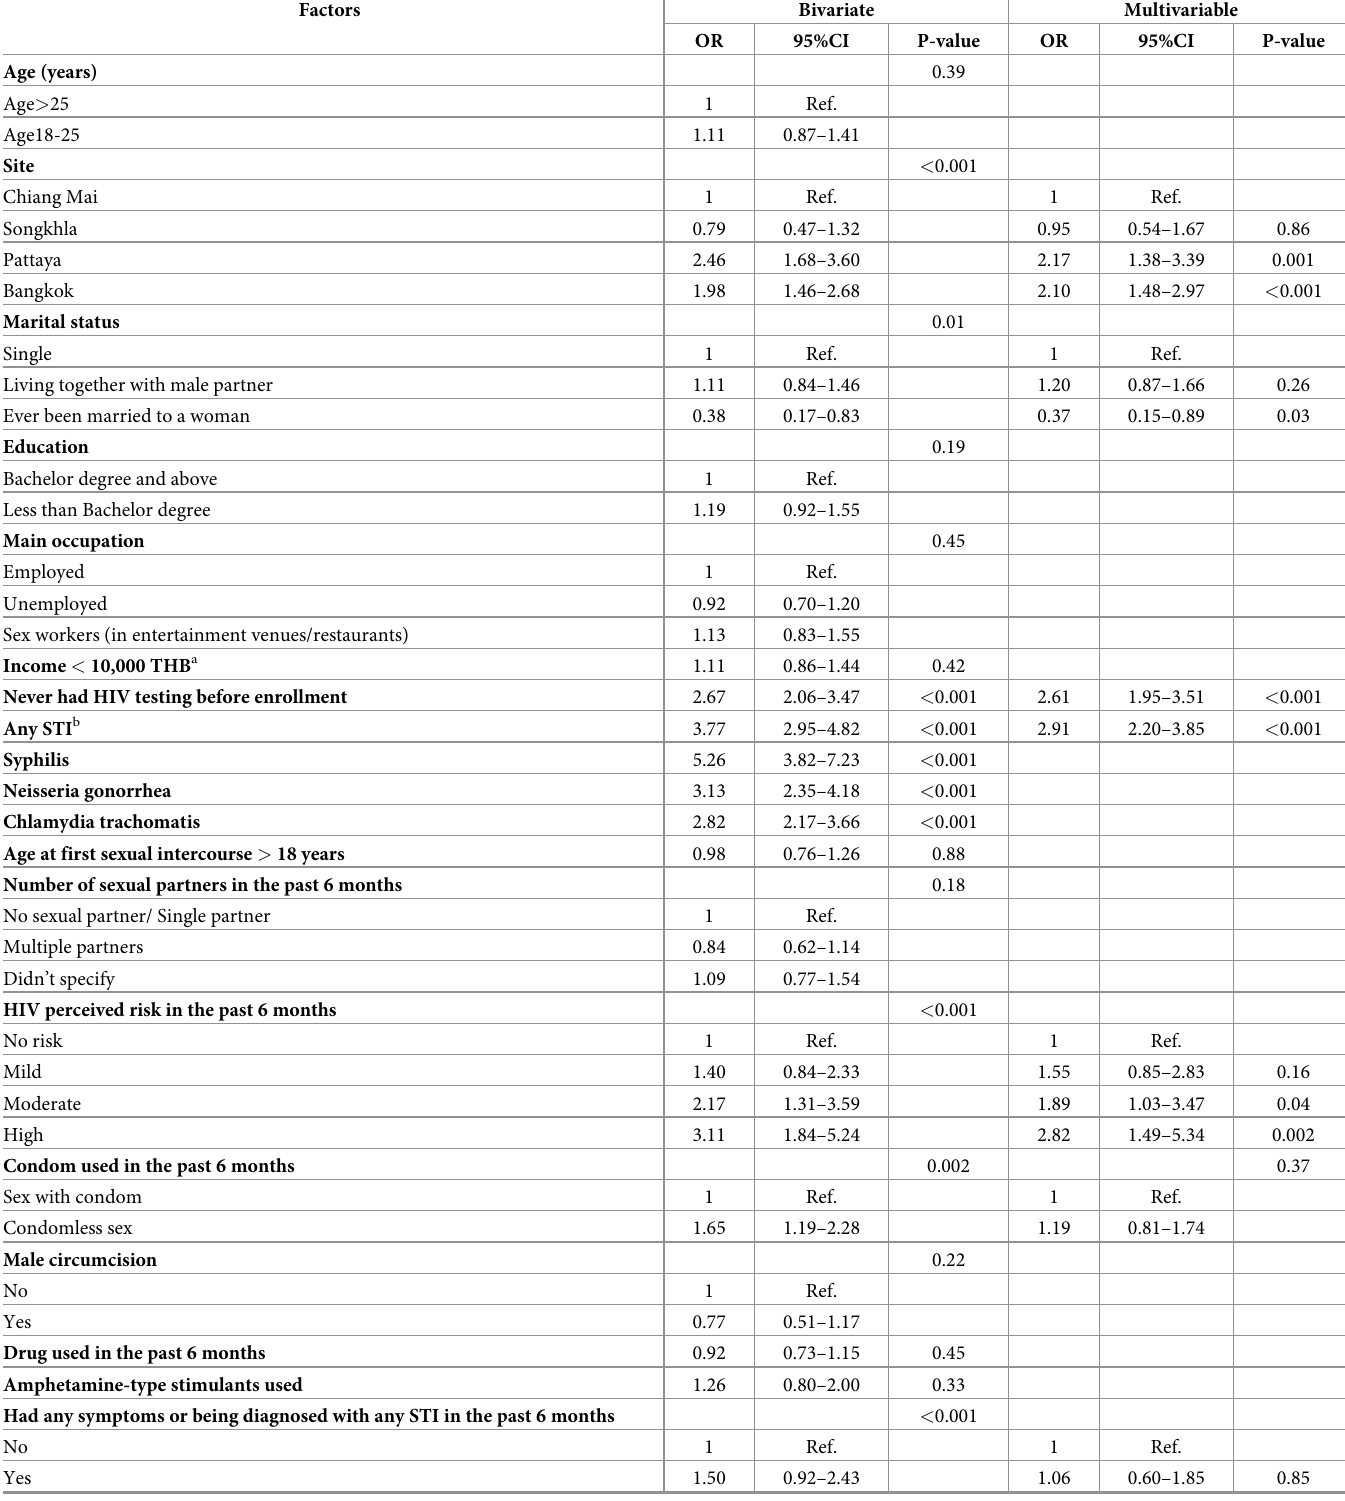
Table 3. Logistic regression of factors associated with HIV prevalence for MSM (N =